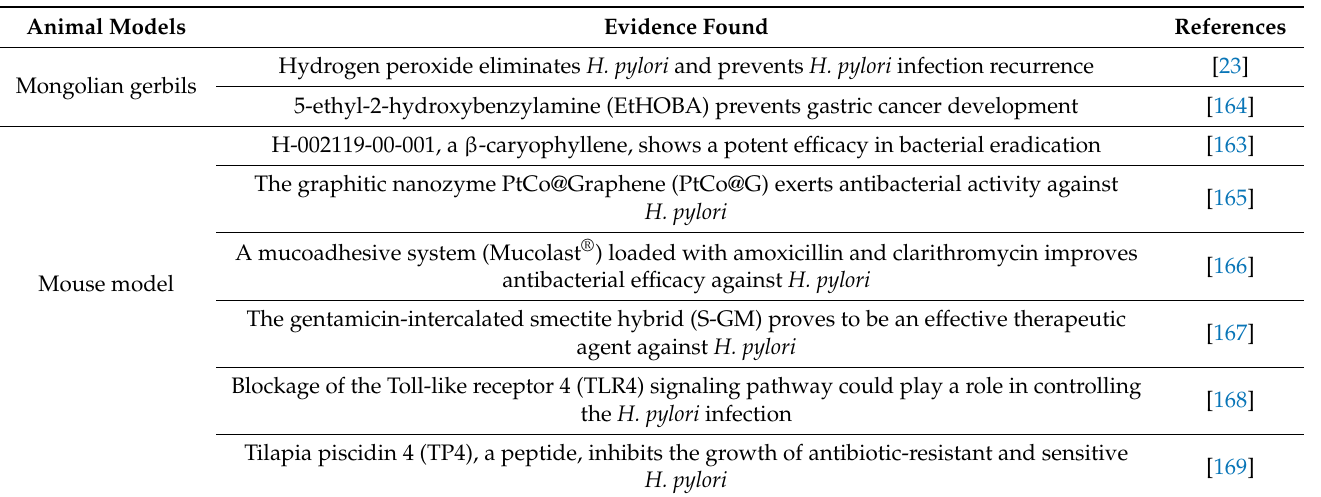
Table 5. Animal models in evaluating